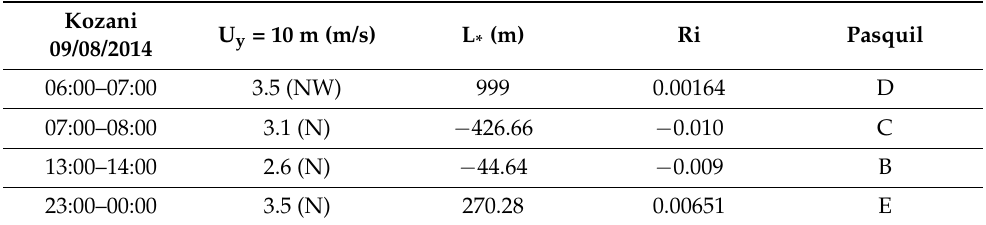
Table 1. Characterization of four stability conditions over Kozani, Greece at different times on 9 August 2014, based on TAPM mesoscale calculations.